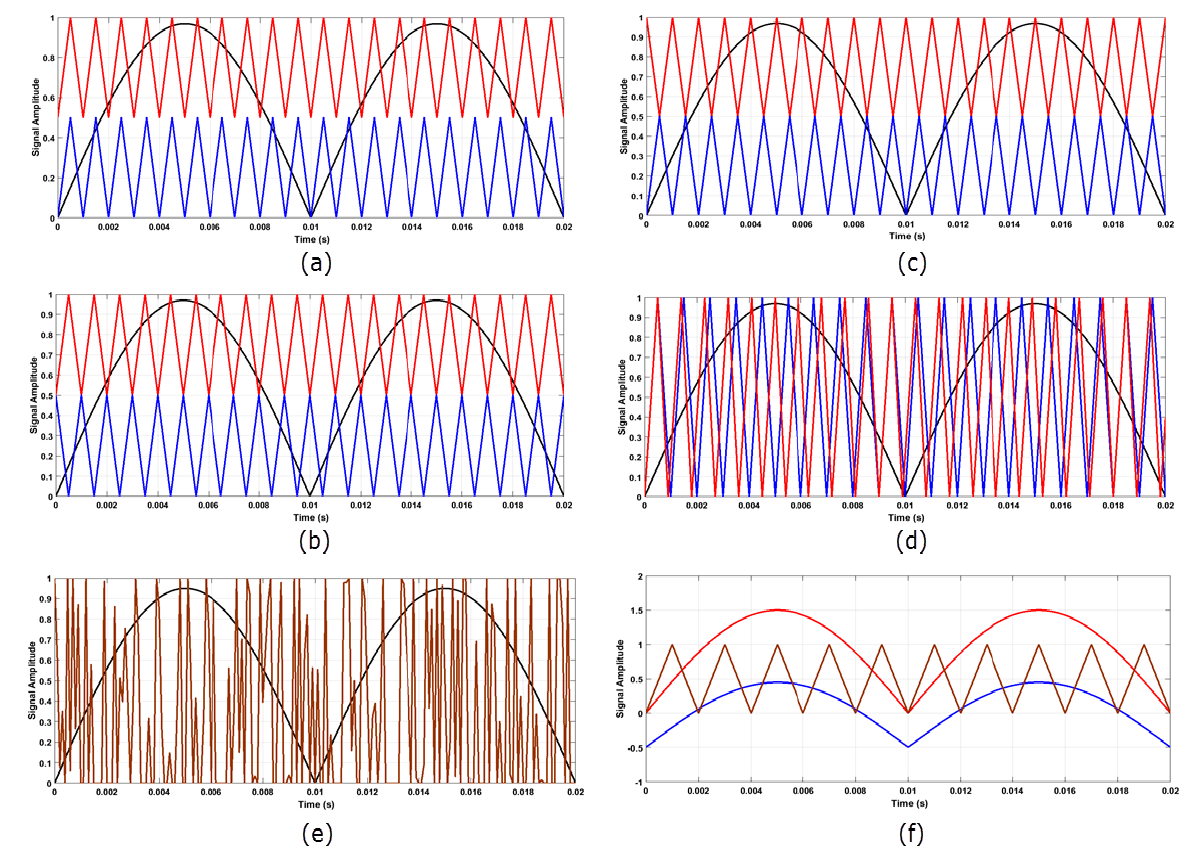
Figure 15. SPWM modulation techniques for five-level inverter: ( a ) PD, ( b ) POD, ( c ) APOD, ( d ) PSPWM, ( e ) RPWM, and ( f ) multi references PWM.